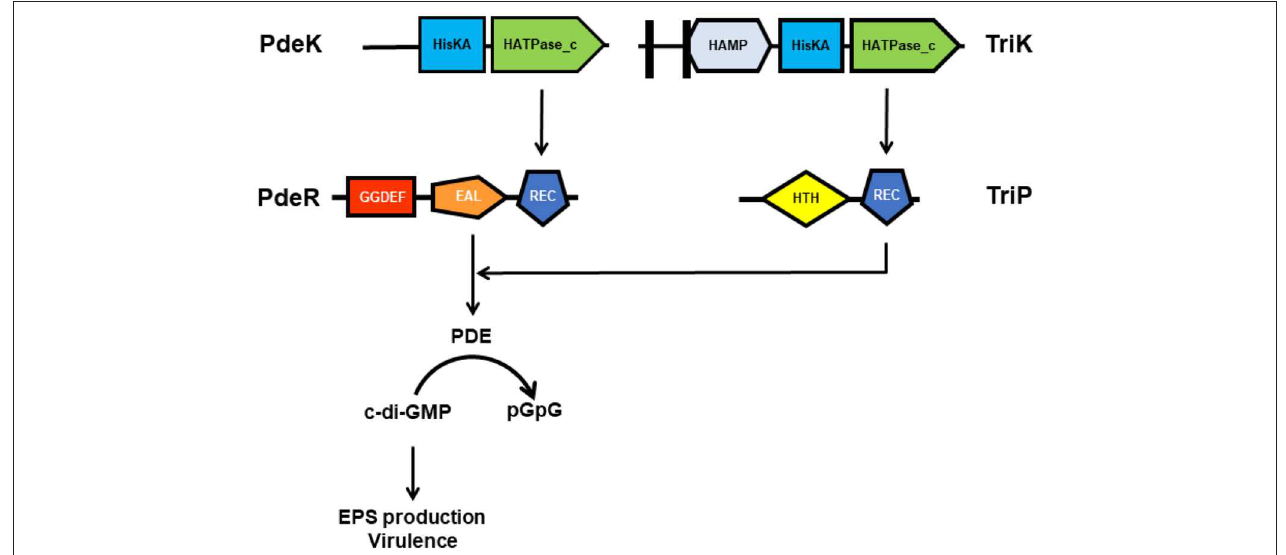
FIGURE 2 | A schematic diagram showing the TriP-PdeR interaction resulting in enhanced PDE activity of PdeR in the presence of PdeK in Xanthomonas oryzae pv. Oryzae. PdeR functions as a PDE for c-di-GMP hydrolysis and forms a TCS with PdeK. TriP specifically interacts with the EAL domain of PdeR via the REC domain. The TriP-PdeR interaction significantly enhances PdeR’s PDE ability for degradation of c-di-GMP into pGpG, thereby promoting EPS production and bacterial virulence in a c-di-GMP-dependent manner.